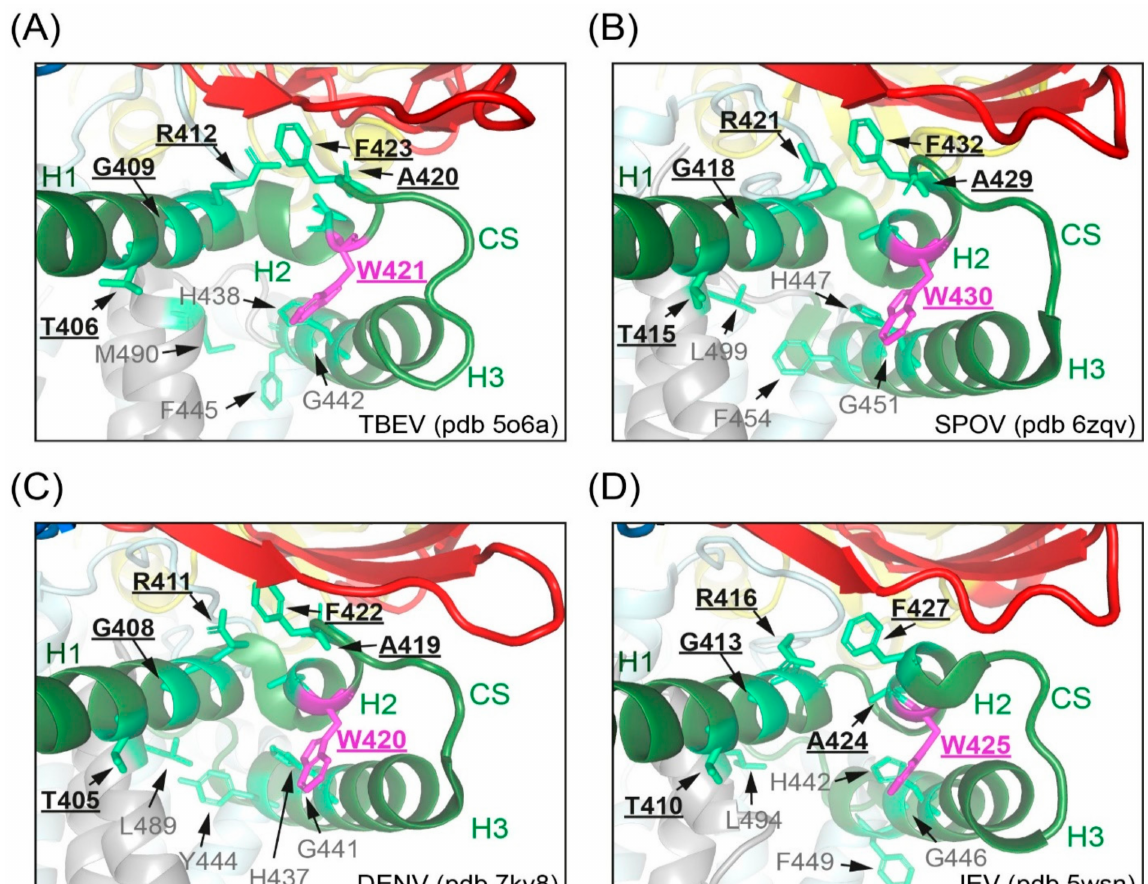
Figure 9. Stem residue W421 in the CS of TBEV and mosquito-borne flaviviruses. Close-up views of sites identified in Spondweni and dengue viruses as lipid-binding pockets [11,12] in mature TBEV ( A ), Spondweni virus ( B ), dengue virus serotype 2 ( C ), and Japanese encephalitis virus ( D ). Color code: E protein domain I, red; E protein stem, green; transmembrane (TM) domains, gray. W in the CS is shown in magenta and residues involved in lipid binding are shown in light green, respectively. Residues of lipid-binding site 1 are underlined and in bold, those of site 2 in grey [11,12].The structures were generated with PyMol (https://pymol.org, accessed on 5 July 2021) using the cryo-EM data of pdb files 5o6a [9], 6zqv [11], 7kv8 [12] and 5wsn [8]. TBEV, tick-borne encephalitis virus; SPOV, Spondweni virus; DENV, dengue virus; JEV, Japanese encephalitis